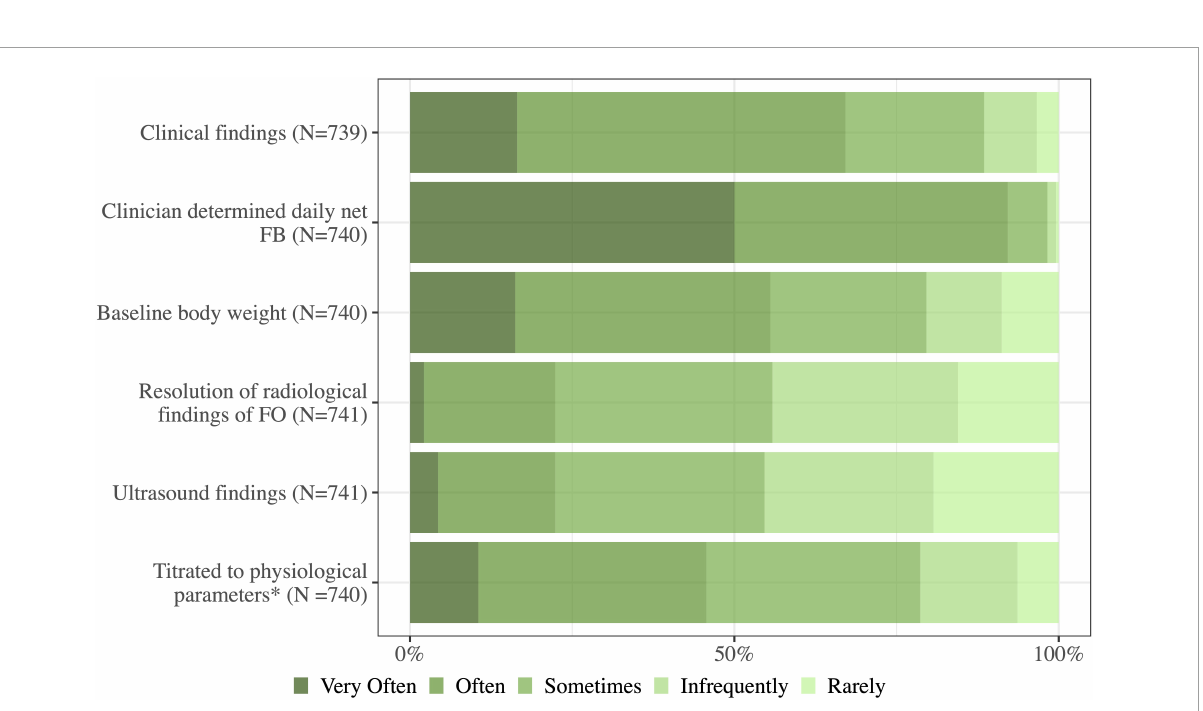
FIGURE6 How often do you use the following approaches in the management of fluid overload in your daily practice? Fluid removal targeted to: FO, fluid overload; FB, fluid balance; N, number of respondents to the question. ∗ Fluid removal titrated to physiological parameters (cardiac output measurements, blood pressure, and gas